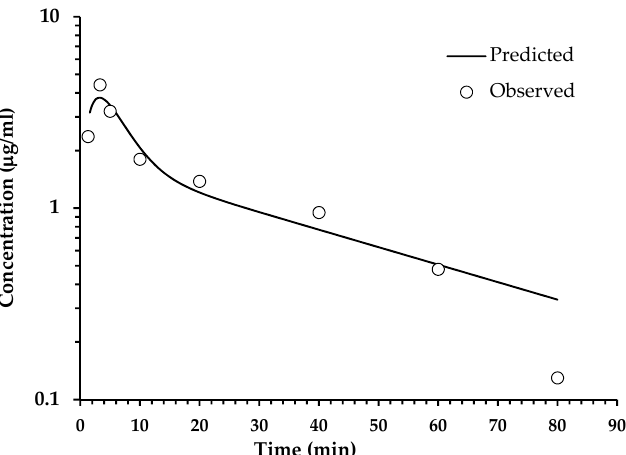
Figure 3. Analysis of variation of the sphaeralcic ‐ acid concentrations in plasma with respect to the time in minutes, after oral administration (400 mg/kg) of the SaTSS standardized fraction. The line represents the prediction of the behavior of the concentration following a two ‐ compartment model.